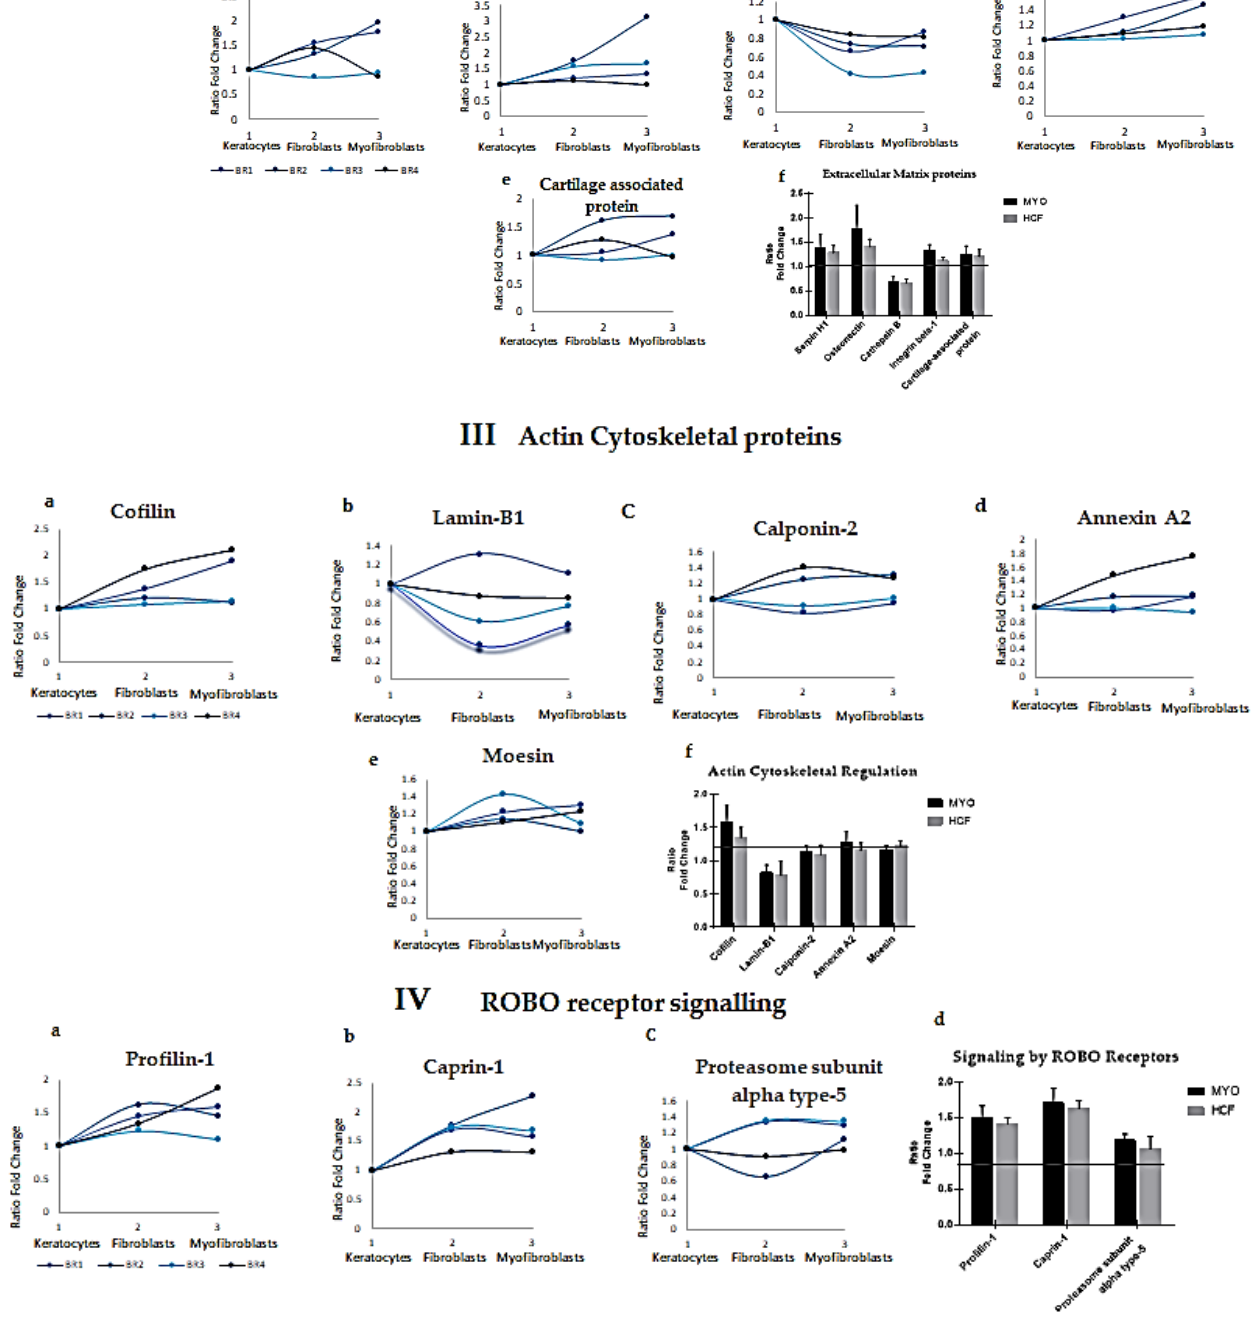
Figure 3. Significantly altered functional classes of proteins during stromal cell differentiation. Pan- ther, KEGG and Reactome pathway analysis of the significantly altered proteins revealed actin cytoskeleton regulation, integrin signaling pathway, ROBO receptor signaling proteins and extra- cellular matrix proteins as the most significantly altered pathways in corneal stromal cell differen- tiation. ( I ) Integrin signaling. (a–c) represent the expression of Rap-1b, F and TLN in fibroblasts and myofibroblasts across all biological replicates. (d) Data represented as standard deviation from all four biological replicates, Ras-related protein (HCF (FC = 0.91), MYO (FC = 0.77)), fibronectin (HCF (FC = 1.07), MYO (FC = 1.31)), talin (HCF (FC = 1.20) and MYO (FC = 1.20)). ( II )